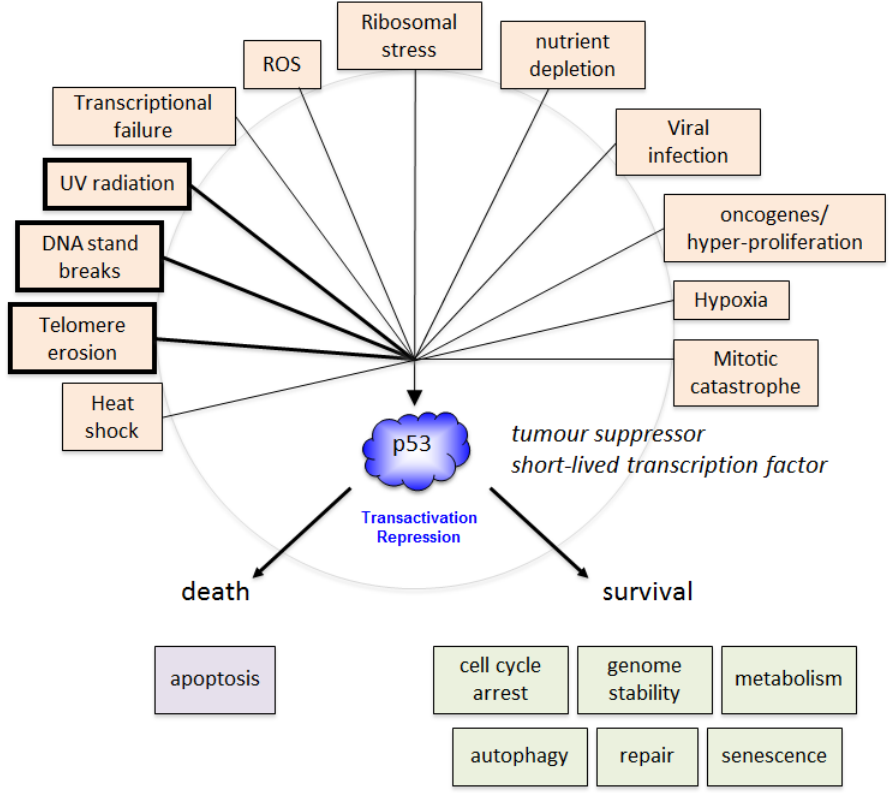
Figure 1. Stress stimuli that lead to p53 induction. A wide range of cellular stress stimuli induce p53 leading to coordinated changes in gene expression and various biological outcomes, depending on the cell type and the type, intensity and duration of the activating stress. Those stimuli for which there is unequivocal evidence that phosphorylation events encompass part of their mechanisms of action are indicated by heavy